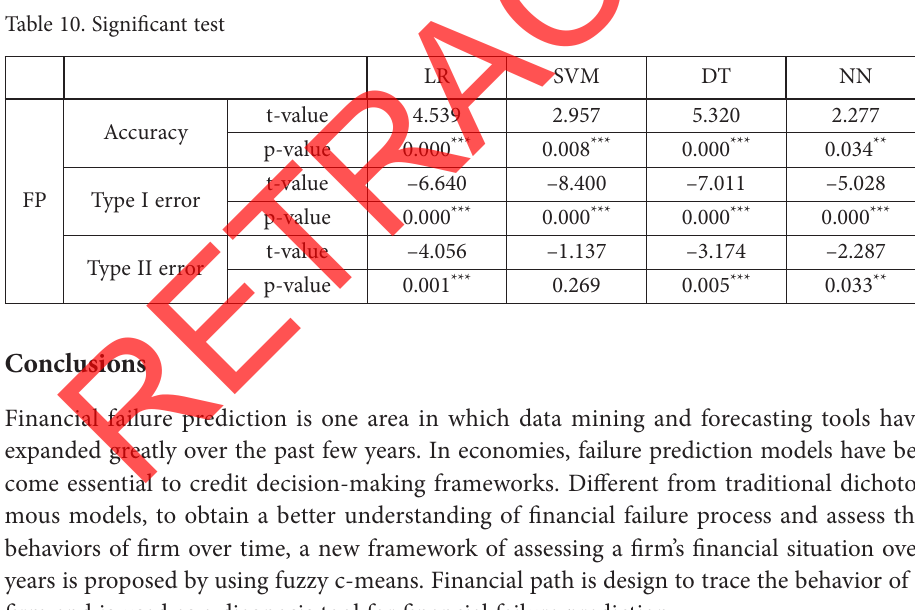
Table 10. Significant